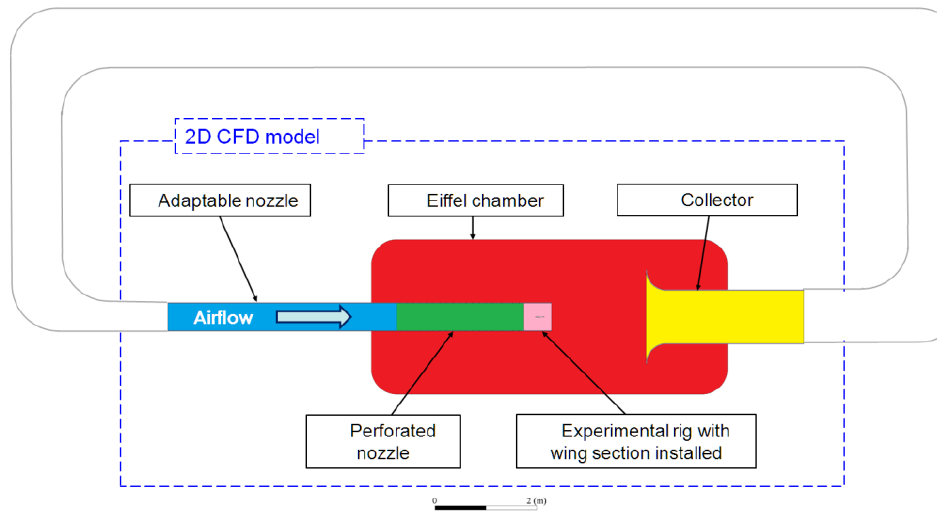
Figure 1. Scheme of the wind tunnel.